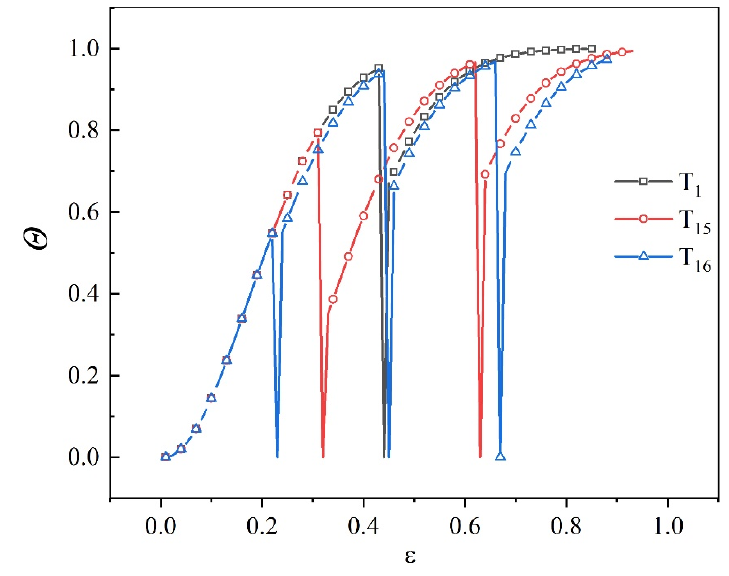
Figure 11. Softening fraction of 300M steel in triple-pass and quadruple-pass compression.